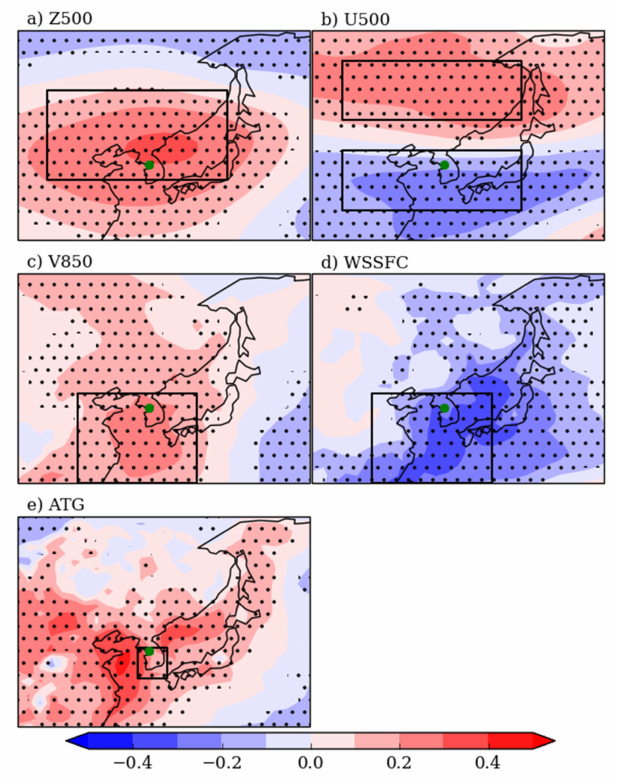
Figure 3. Spatial correlations of PM 10 in Seoul (37.5N, 127E) with a ( a ) geopotential height at 500 hPa, ( b ) u-wind component at 500 hPa, ( c ) v-wind component at 850 hPa, ( d ) 10 m surface wind speed, and ( e ) potential air temperature gradient, respectively. Green dots denote the location of Seoul; black boxes denote the regions for the calculation of 5 indices (Z500, U500, V850, WSSFC, and ATG) during the winters of the 2001 − 2014 period, respectively. The black dotted areas indicate significant regions at the 95% confidence level based on the Student’s t -test.